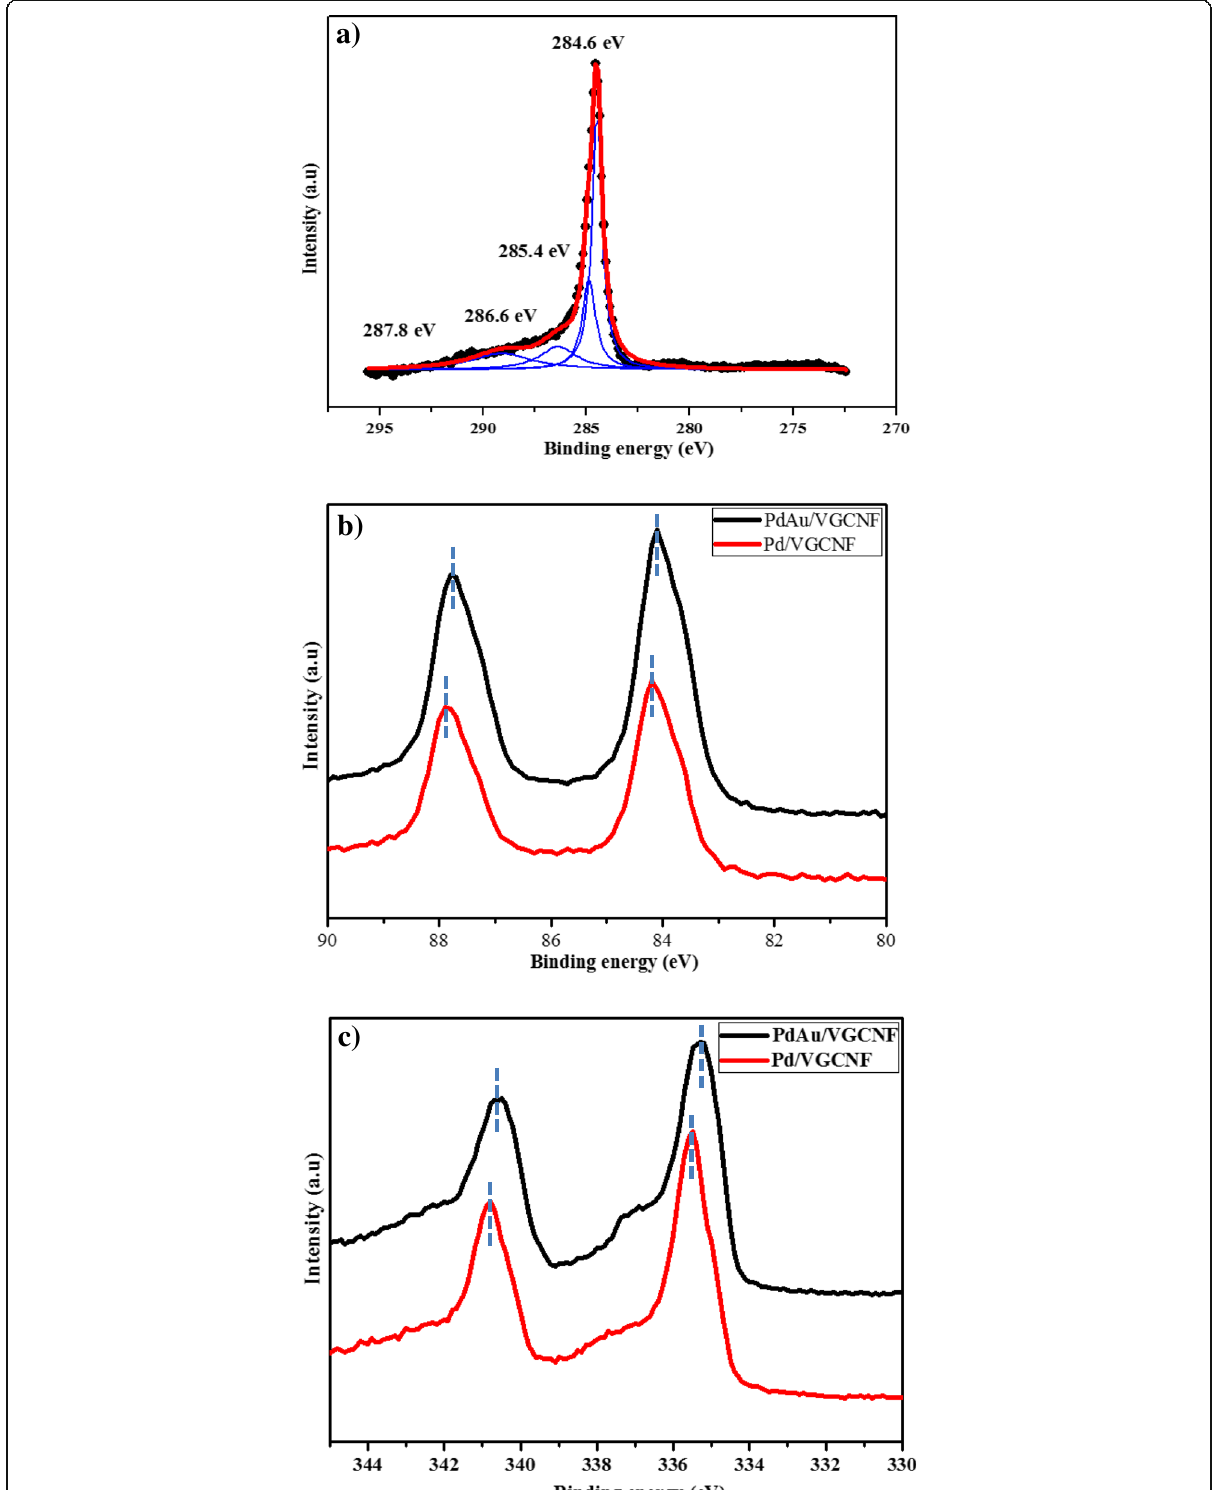
Fig. 4 High-resolution XPS spectra of Pd/VGCNF, Au/VGCNF, and Pd 1 Au 1 /VGCNF. a Pd 4 f 5/2 and Pd 4 f 7/2 . b Au 4 f 5/2 and Au 4 f 7/2 and c C 1